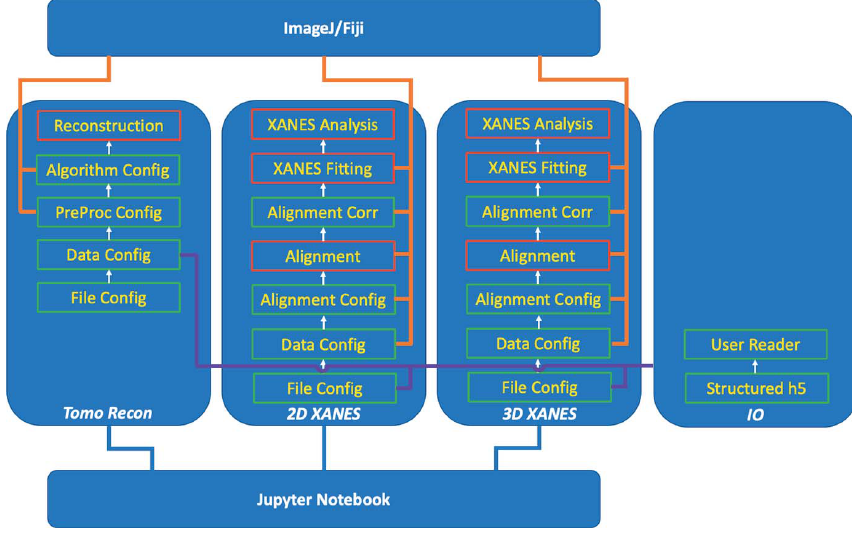
Figure 1 TXM-Sandbox software structure. Python scripts are generated in the steps marked with red